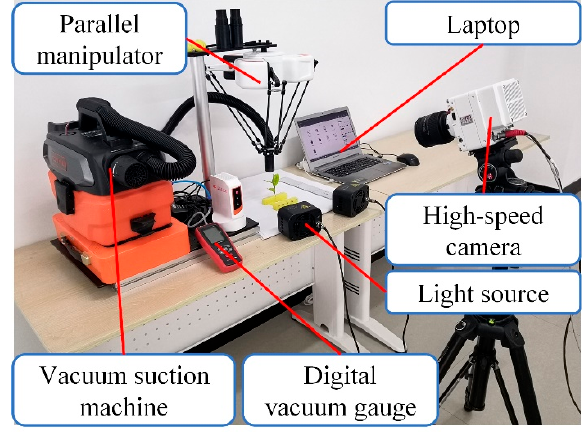
Figure 10. Experimental platform.